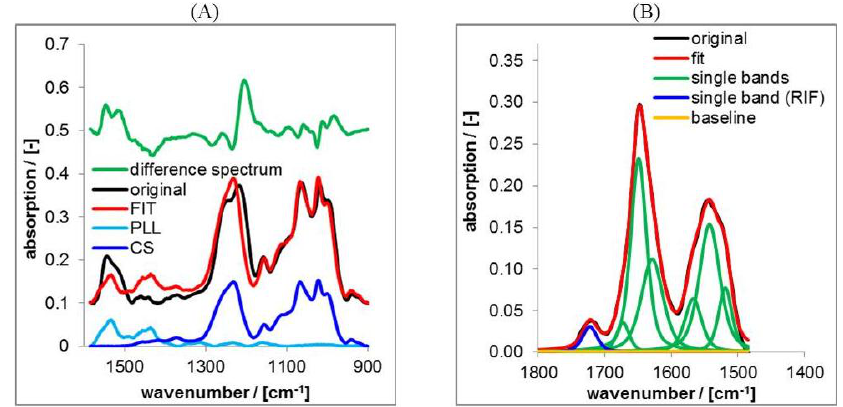
Figure 3. ( A ) Typical result of factor analysis on attenuated total reflection Fourier transform infrared spectroscopy (ATR-FTIR) spectra of casted films of PLL/CS-1.0; ( B ) Typical result of lineshape analysis (LSA) on ATR-FTIR spectra of casted films of PLL/CS-1.0 loaded by